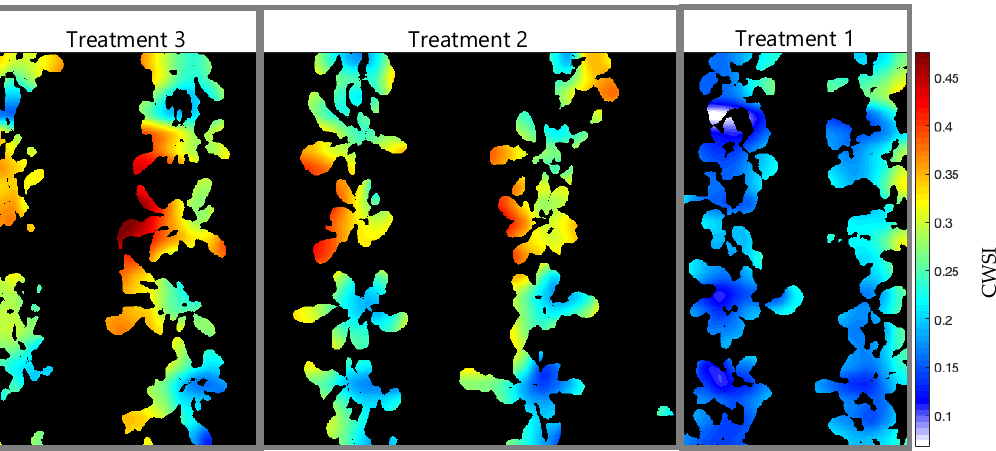
Figure 15. CWSI (Crop Water Stress Index) map generated for 25DAP (Day After Planting), using the empirical method to obtain the T UL (Temperature Upper Limit) and T LLN (Temperature Lower Limit) through natural reference surfaces. One of the leaves was wetted with water to simulate 100% transpiration and the other was covered with Vaseline to block leaf transpiration. Treatment 1 (T 1 = 85% FC (Field Capacity)); Treatment 2 (T 2 = 75% FC); Treatment 3 (T 3 = 55% FC).